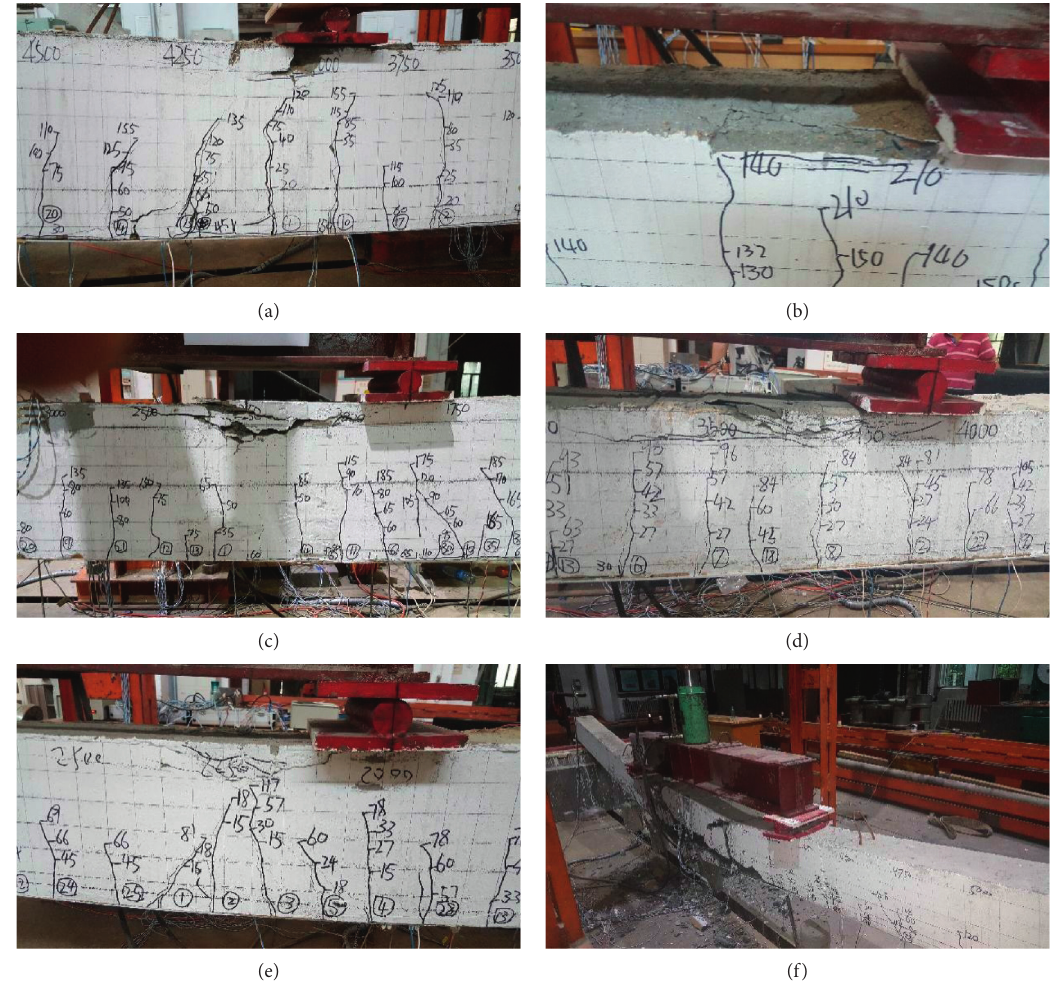
Figure 6: The failure modes picture of the specimens: (a) SL1; (b) SL2; (c) SL3; (d) SS1; (e) SS2; (f) SS3.